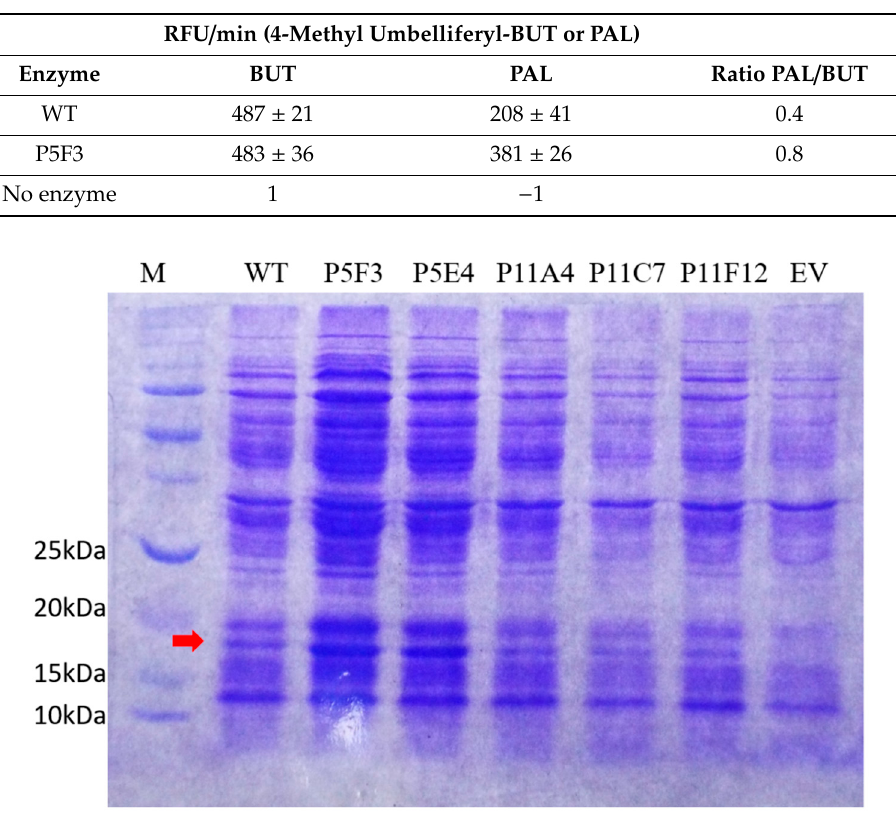
Figure A4. Full SDS-PAGE picture of Figure 3E. (EV = empty vector) the arrow indicates the protein band corresponding to BSLA ( ≈ 19 kDa), which is not present in the empty vector (EV) control.